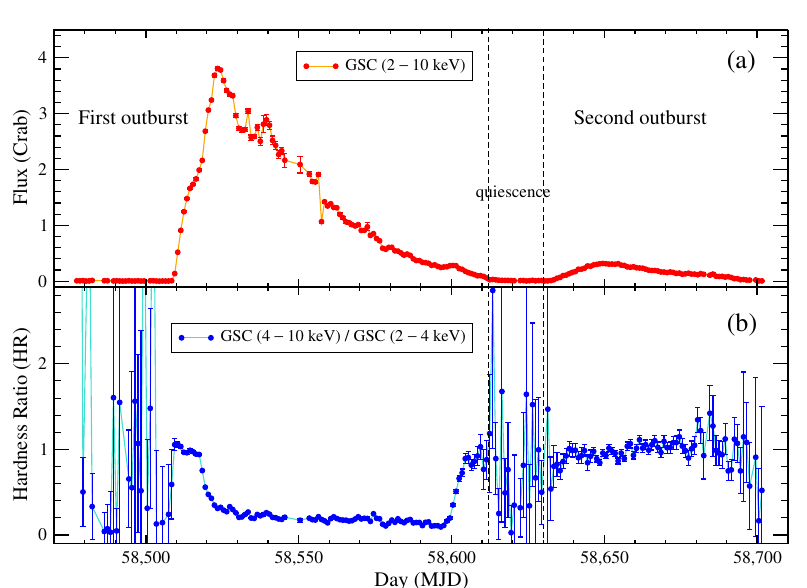
Figure 1. Variation of ( a ) 2–10 keV MAXI/GSC flux and ( b ) hardness ratio (HR) of 4–10 keV